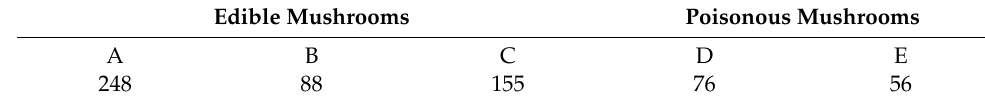
Table 3. K-Folds cross-validation. Table 2. Mushroom dataset.